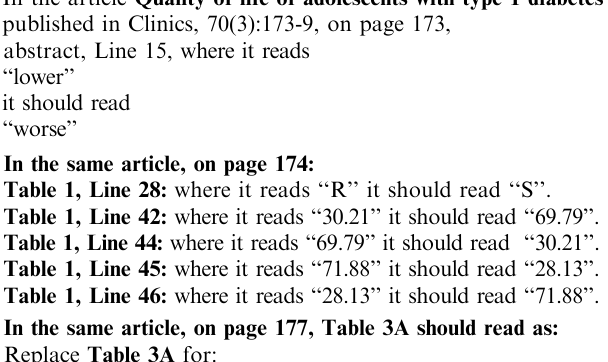
Table 1, Line 28: where it reads ‘‘R’’ it should read ‘‘S’’. Table 1, Line 42: where it reads ‘‘30.21’’ it should read ‘‘69.79’’. Table 1, Line 44: where it reads ‘‘69.79’’ it should read ‘‘30.21’’. Table 1, Line 45: where it reads ‘‘71.88’’ it should read ‘‘28.13’’. Table 1, Line 46: where it reads ‘‘28.13’’ it should read ‘‘71.88’’. In the same article, on page 177, Table 3A should read as: